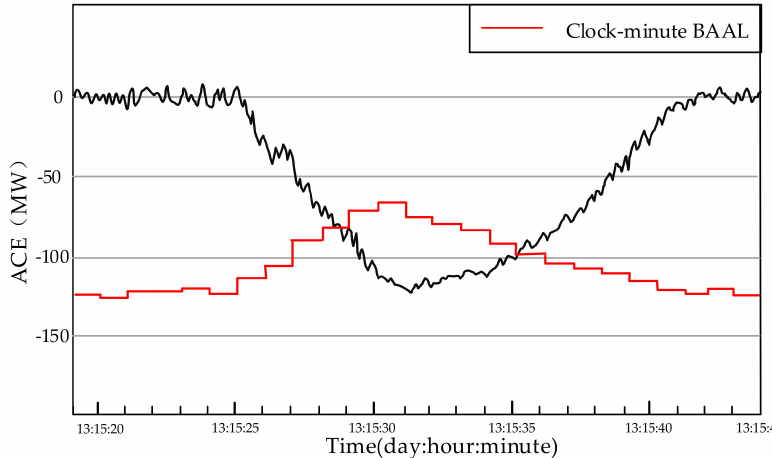
Figure 10. ACE fluctuation of area 2 over some time with the BAL-001-2 control